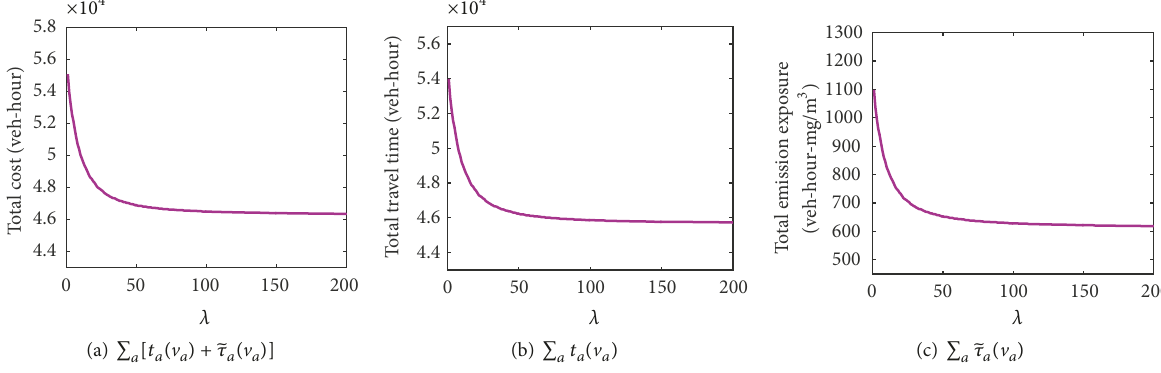
time, and the total cost all get reduced, i.e., Pareto improving solutions are